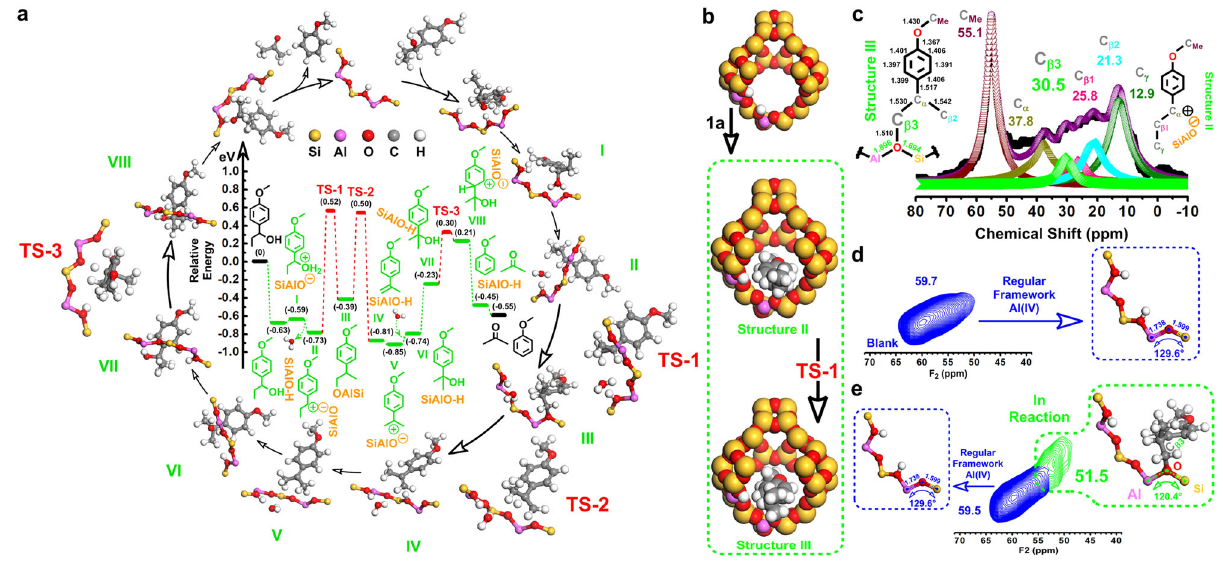
Fig. 3 Mechanistic study for the transformation of the C sp2 – C sp3 bond. a Energy pro fi le for transformation of the C sp2 – C sp3 bond. Reaction intermediates ( I – VIII ) and transition states ( TS , 1 – 3 ). [SiAlO], the Bronsted acid center in the RuW/HY 30 catalyst. b Space- fi lling models of the Bronsted acid center and intermediate structures (Structures II and III) in a . c Core bond metrics of structure III and 13 C NMR analysis of the C – C bond evolution in reaction of 1a , black solid square ( ■ ) represents the observed intensities, purple circle marks ( ) is the total fi tting curve, dark yellow regular triangle upward ( ), pink right triangle ( ), cyan hollow left triangle ( ), green diamond ( ), olive hollow hexagon ( ) and wine regular triangle downward ( ) represent the fi tting curves of C α , C β 1 , C β 2 , C β 3 , C γ and C Me , respectively. Reaction conditions: 1a (1 mmol), RuW/HY 30 catalyst (0.20 g, 2.5 wt% Ru, 14 wt% W), H 2 O (5.0 ml), 180 °C, 10 min, 0.1 MPa N 2 , 800 rpm. d 27 Al MQMAS analysis of the boiled RuW/HY 30 catalyst in the blank experiment, blue loops represent the regular framework Al(IV), F2, Fourier transformation in the directly detected dimension. Reaction conditions: RuW/HY 30 catalyst (0.20 g, 2.5 wt% Ru, 14 wt% W), H 2 O (5.0 ml), 180 °C, 10 min, 0.1 MPa N 2 , 800rpm. e 27 Al MQMAS analysis of the RuW/HY 30 catalyst in reaction of 1a , blue and green loops represent the regular framework Al(IV) and the framework Al(IV) in the [Al – O(C β 3 ) – Si] center (Structure III, a ), respectively. Reaction conditions are the same as that in c